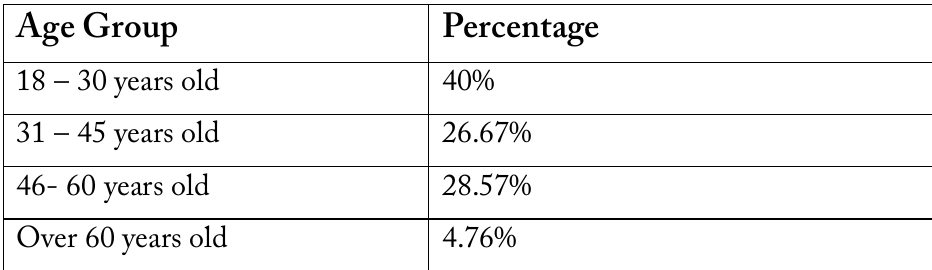
Table 1: Age groups and percentage of participants that fell into each